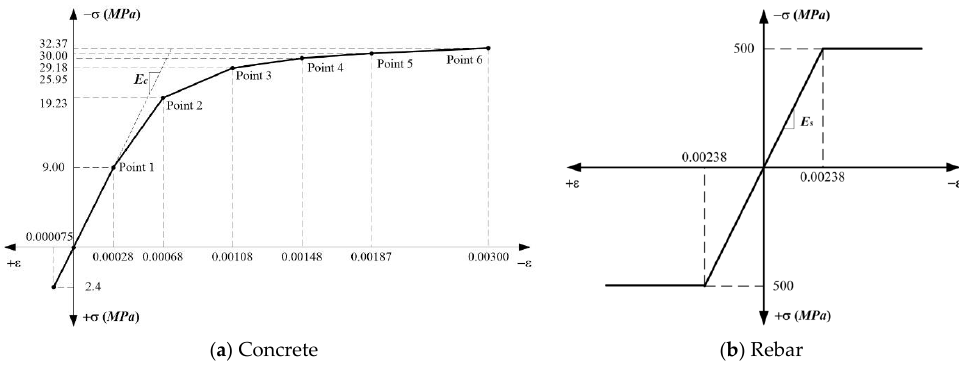
Figure 6. Strain–stress curves for concrete and steel reinforcement.